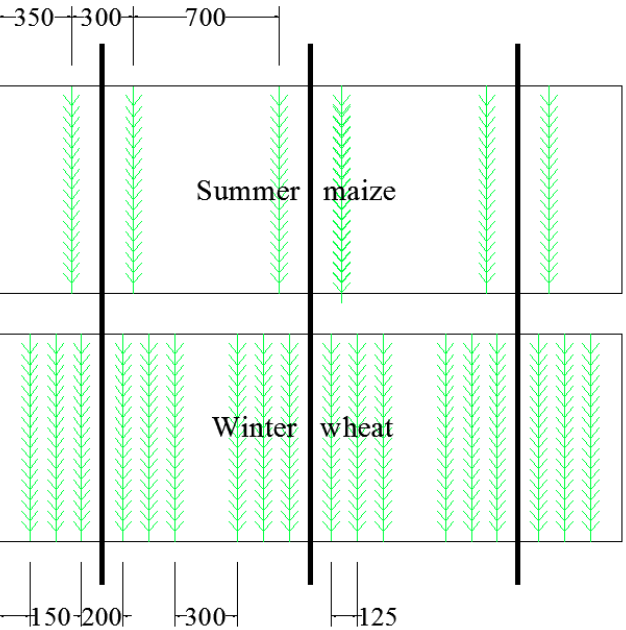
Figure 2. The planting pattern of summer maize and winter wheat (cm). Note(s): The vertical black lines represent drip irrigation belts .